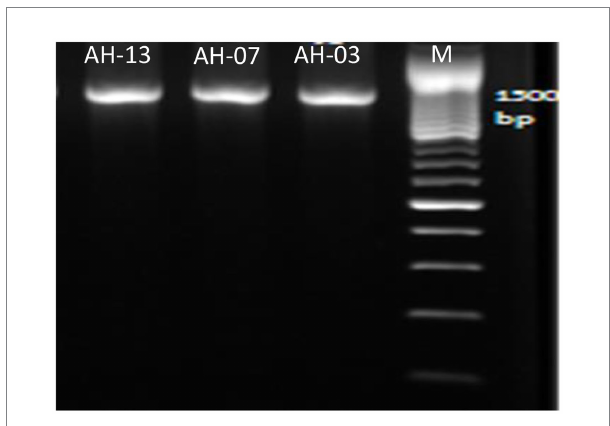
FIGURE 1 Amplified DNA of the 16S rRNA gene for the selected isolates with primer pair 27F and 1492R, Lane 1: 100 bp DNA markers; Lane 2: strain AH-03; Lane 3: strain AH-07 and Lane 4: strain